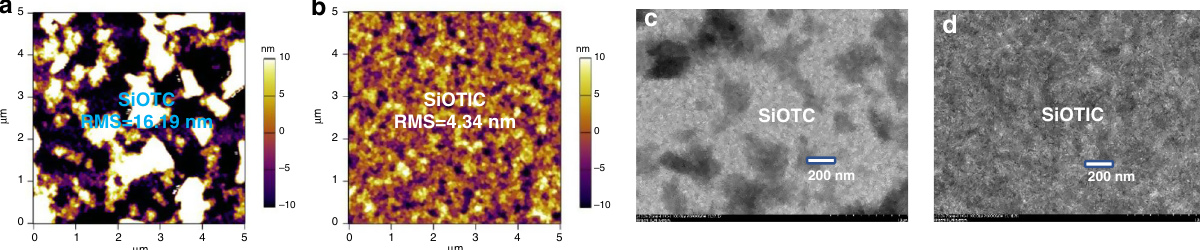
Fig. 6 AFM and TEM images of the PM6:SiOTC and PM6:SiOTIC blend fi lms. a AFM images (5 μ m × 15 μ m) of the PM6 : SiOTC blend fi lm. b AFM images (5 μ m × 15 μ m) of the PM6 : SiOTIC blend fi lm. c TEM image of the PM6 : SiOTC blend fi lm. d TEM image of the PM6 : SiOTIC blend fi lms.